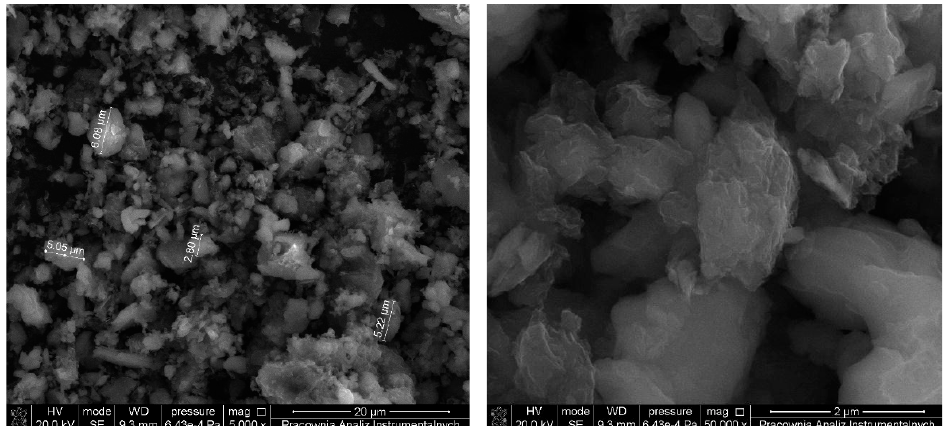
Figure 2. SEM images of the shungite with magnification ( A ) 5000 × and ( B ) 50,000 × .